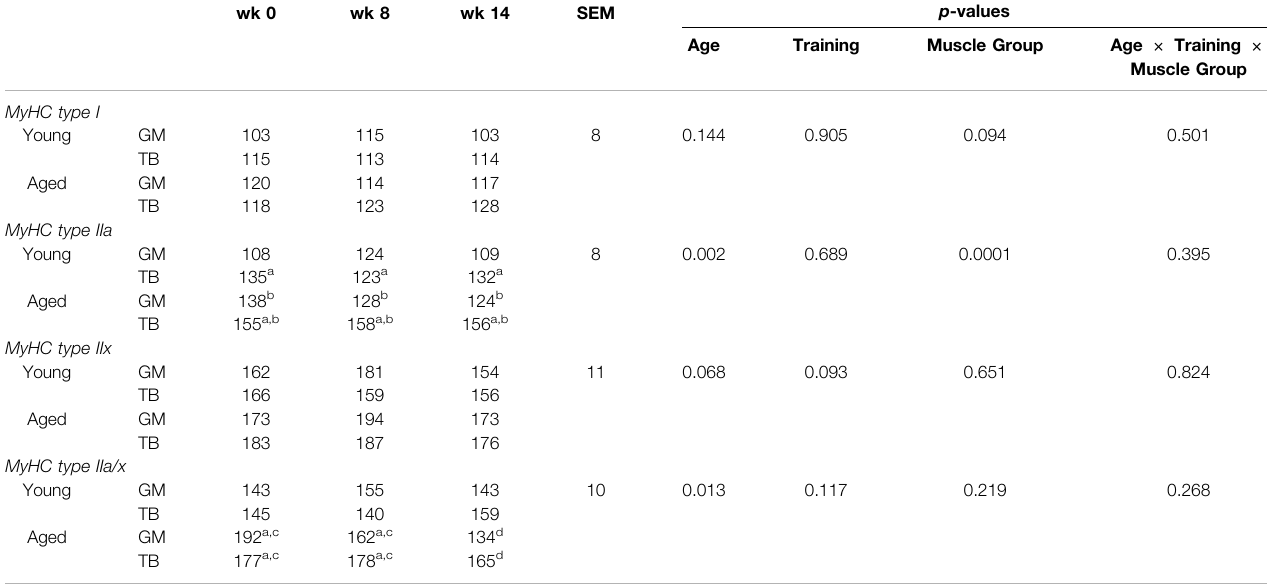
TABLE 2| Minimumferet diameter (A.U.) ofgluteusmedius(GM)and triceps brachii (TB)myosin heavy chain (MyHC)type I, type IIa,type IIx,and hybridtype IIa/x before(wk 0) and after 8 (wk 8) and 12 (wk 12) weeks of submaximal exercise training in aged (22 ± 5 yr; n (cid:1) 10) and young (9.7 ± 0.7 mo; n (cid:1) 8)